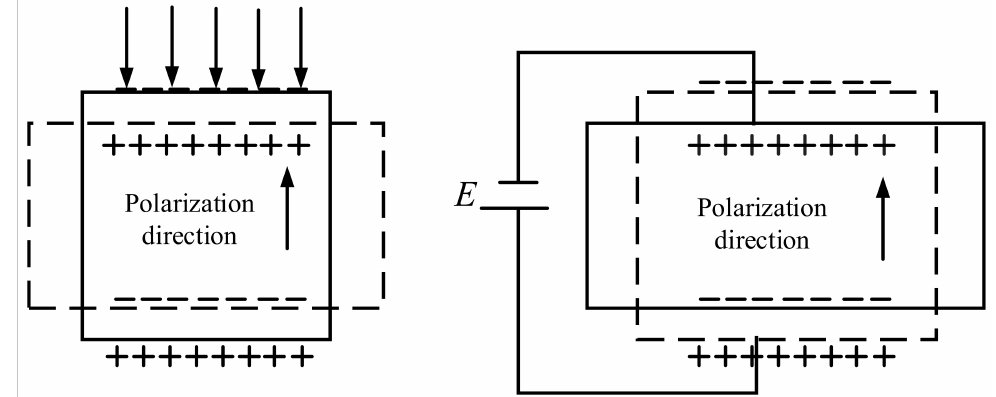
Figure 2. Schematic diagram of direct piezoelectric effect and inverse piezoelectric effect [28].